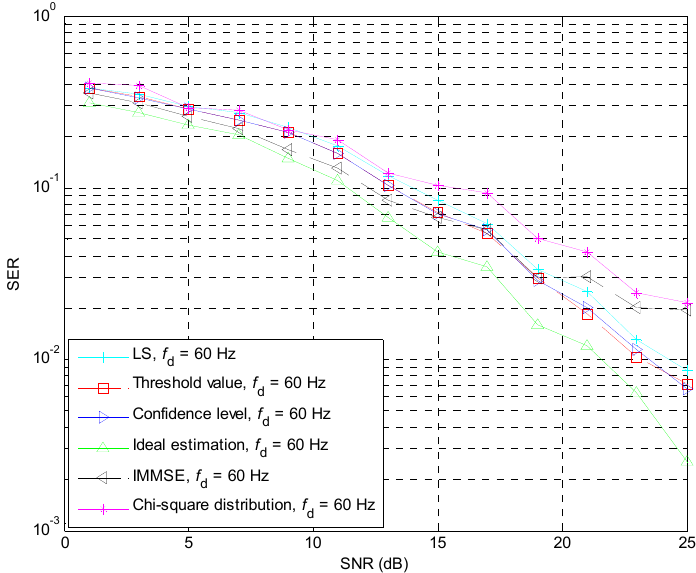
Figure 9. SER performance of the 16 QAM-modulated CP-OFDM system over Brazil B under T 1 =